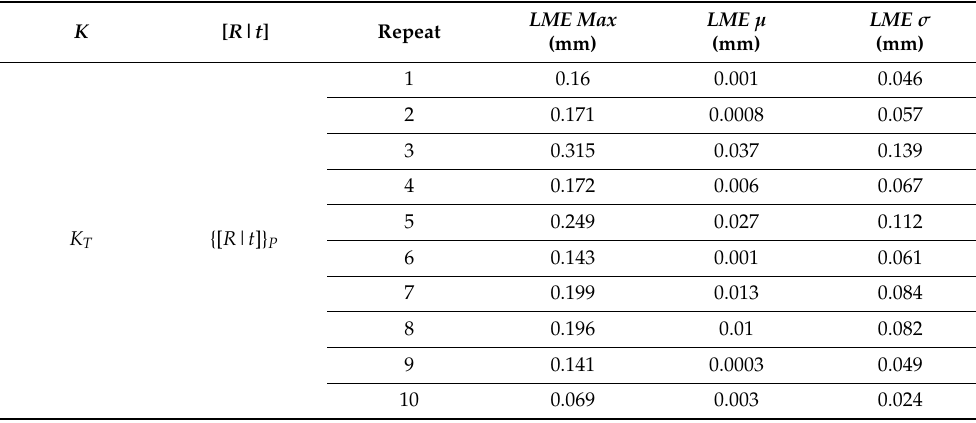
in a 10-repetition P